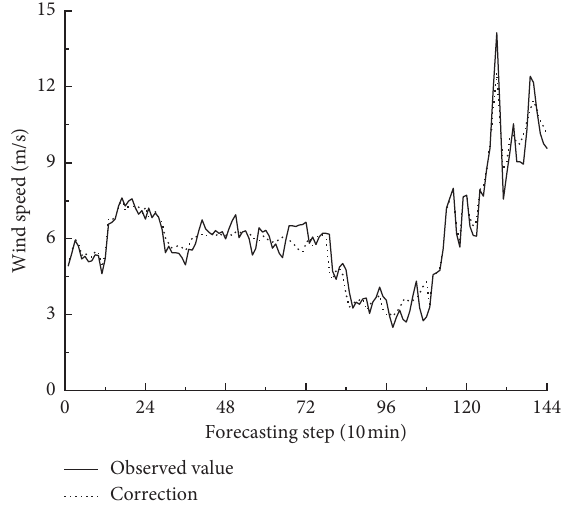
Figure 7: Correction of the Narnet